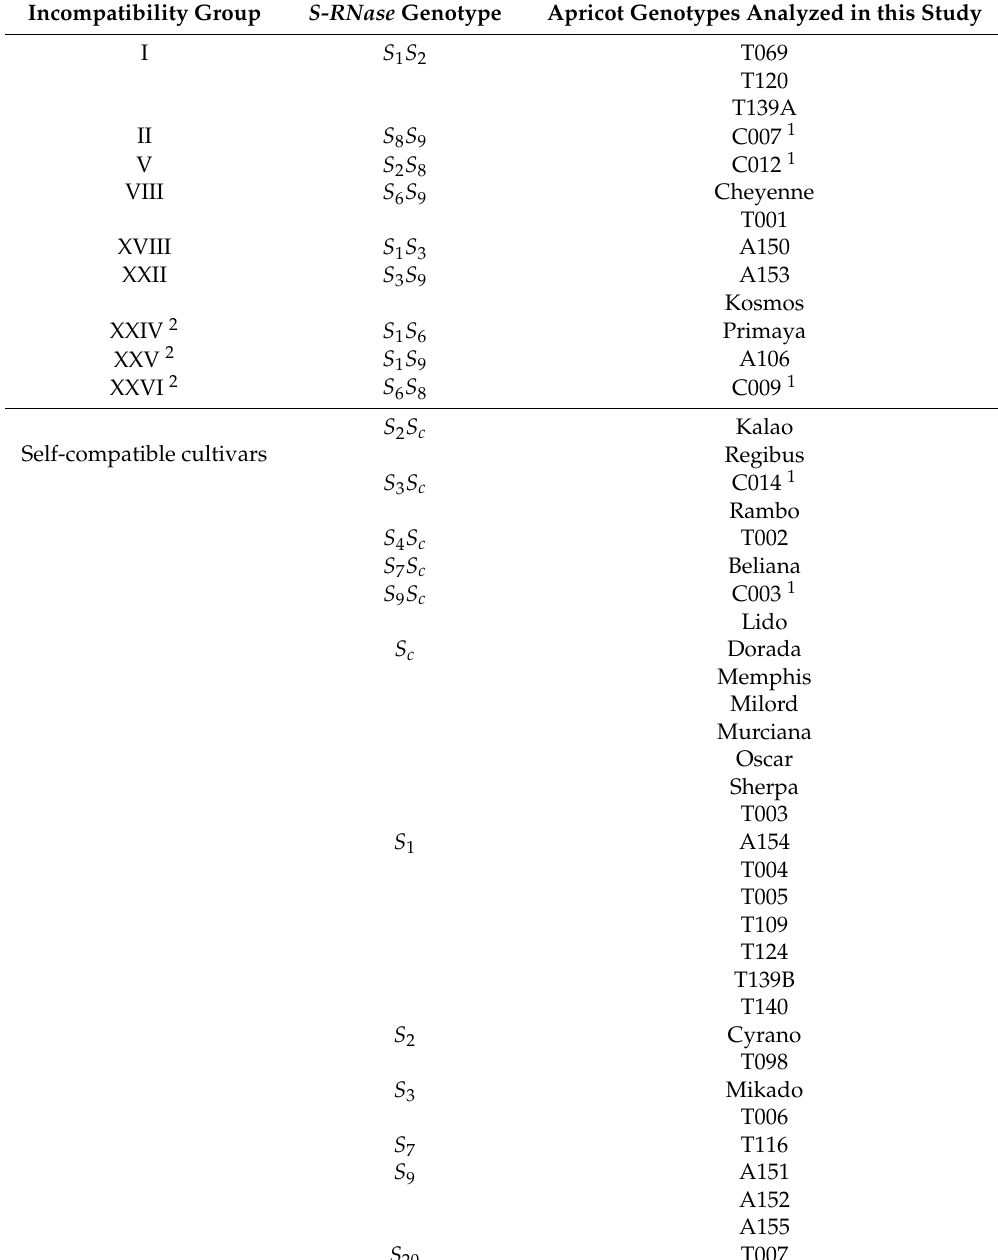
Table 1. Incompatibility groups and S-RNase genotype of the 44 apricot cultivars and selections analyzed in this